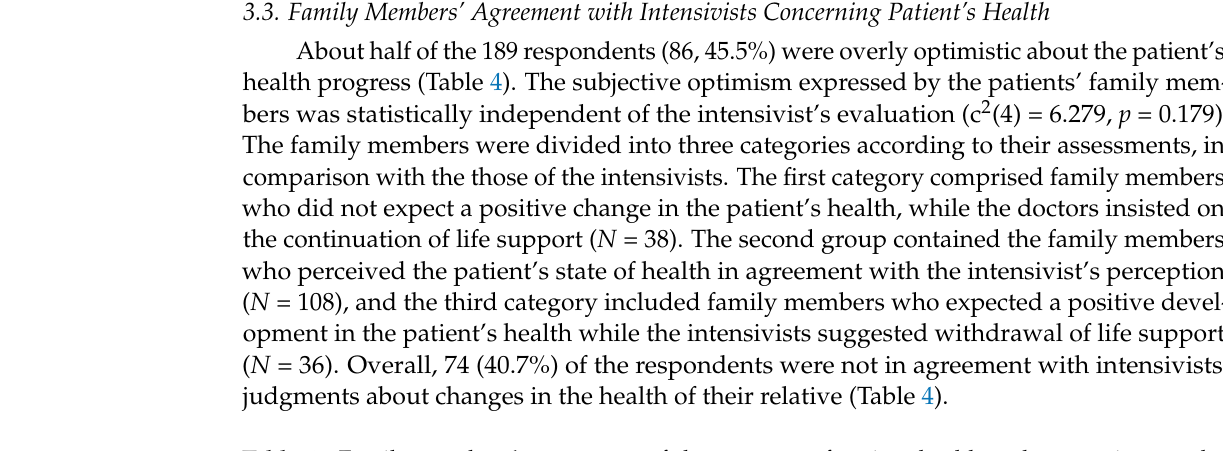
Table 4. Family members’ assessment of the progress of patient health and comparison to the intensivists’